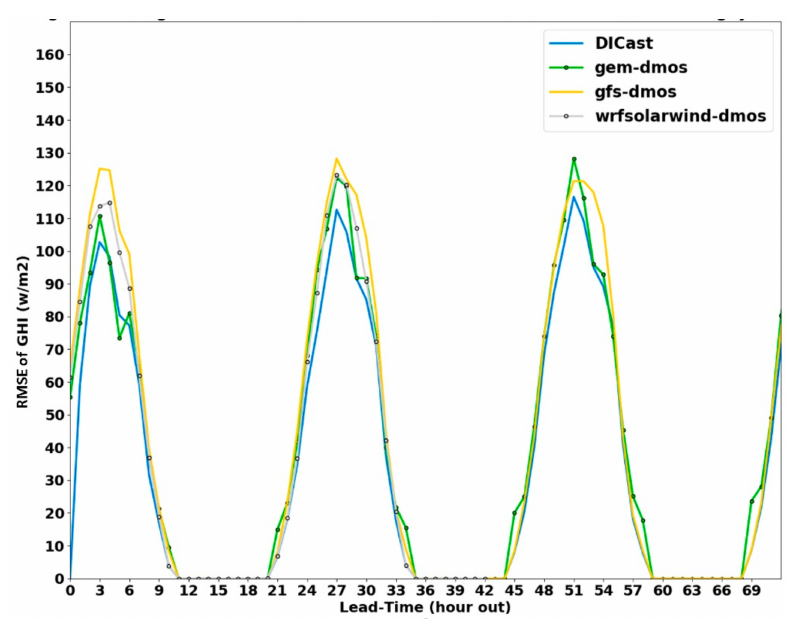
Figure 6. Average RMSE of global horizonal irradiance (GHI) over the period 1 December 2018 to 30 November 2019 for forecasts valid at 06